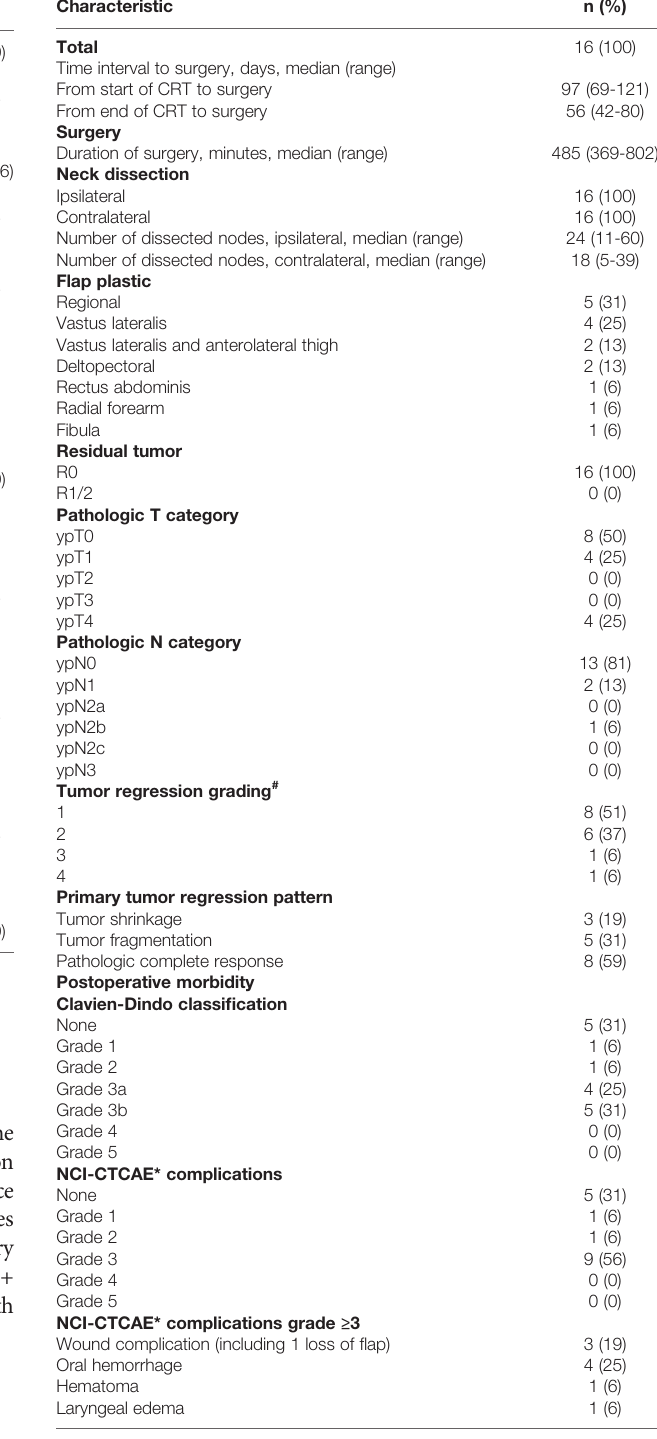
TABLE 2 | Surgical and pathological characteristics of patients who underwent surgery.